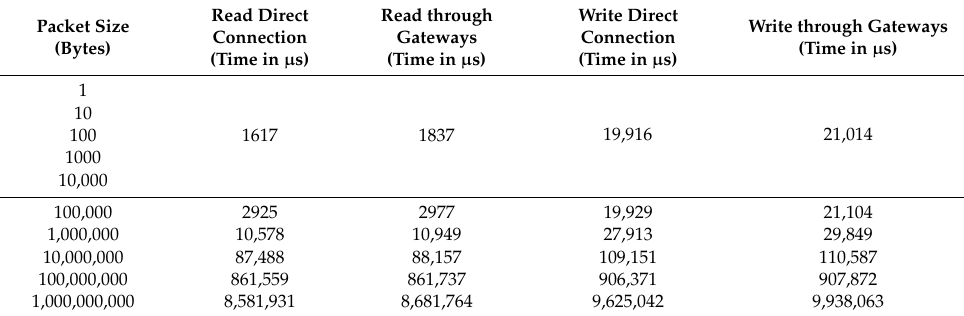
Table 13. Execution time for reading and writing access to Hadoop